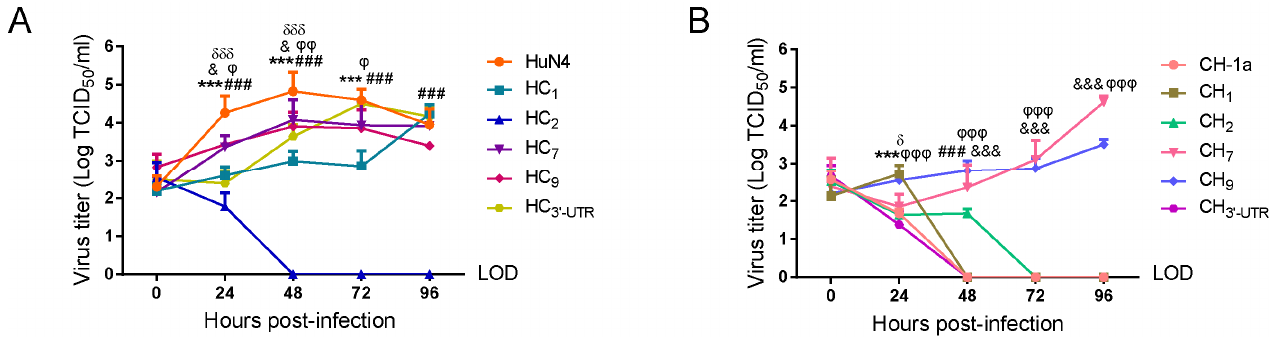
Figure 2. The comparison of replication efficiency between parental and chimeric viruses in PAMs. ( A , B ) The viral titers of parental HuN4, CH-1a and their chimeric viruses in PAMs. The parental and mutant viruses infected PAMs at a MOI of 0.01. The data were presented as the mean standard deviation of three independent experiments. LOD: limit of detection. Asterisk (*) indicates a significant difference between HuN4 and CH-1a and HC 1 and CH 1 , respectively. (***, p < 0.001). Pound (#) indicates a significant difference between HuN4 and CH-1a and HC 2 and CH 2 , respectively. ( ### , p < 0.001). And (&) indicates a significant difference between HuN4 and CH-1a and HC 7 and CH 7 , respectively. (&, p < 0.05; &&&, p < 0.001). Phi ( φ ) indicates a significant difference between HuN4